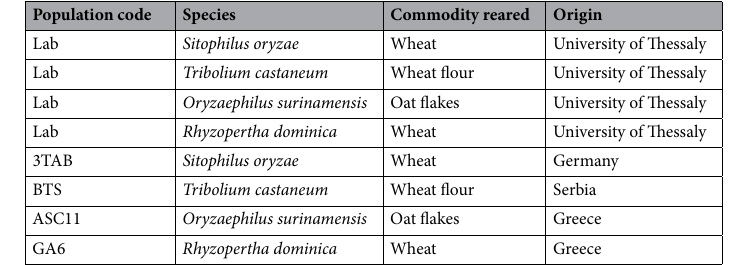
Table 7. Insect species and populations used in